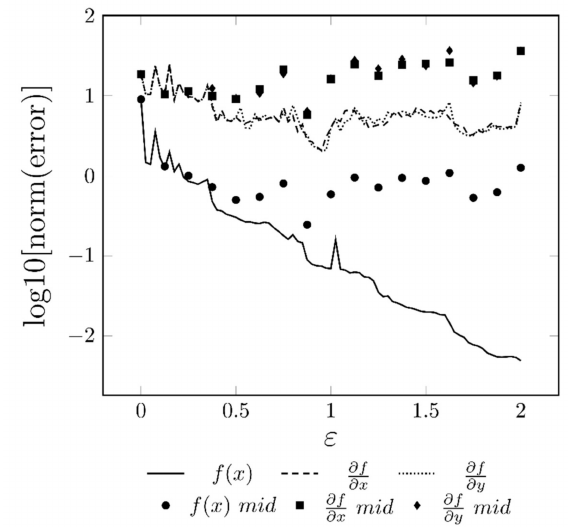
Figure 9. The error of approximating the given function f ( x , y ) and its derivatives using the conven- tional RBF approach as it varies with ε . The Gaussian radial basis function is used and the number of mesh points is fixed as 21 × 21 regularly distributed